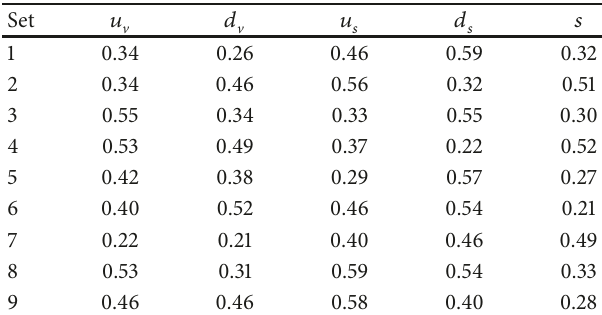
the 𝑊 ± bosons are produced from 𝑞 𝑖 𝑞 𝑗 pairs, with 𝑖 ̸= 𝑗 . For Table 2: Values of the 𝑔 𝑎 𝑁𝑃 parameter in (6) for the flavours 𝑎 =